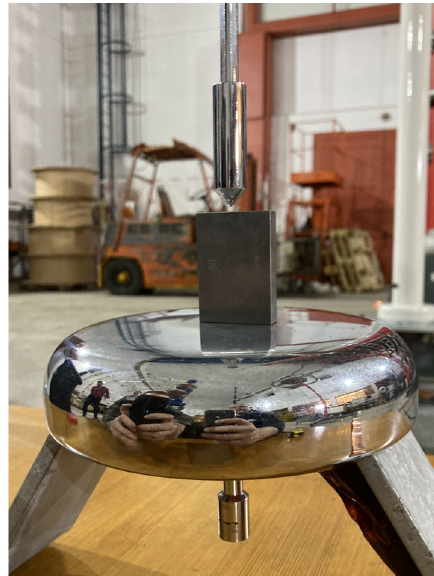
Figure 2. Sight on experimental set up.